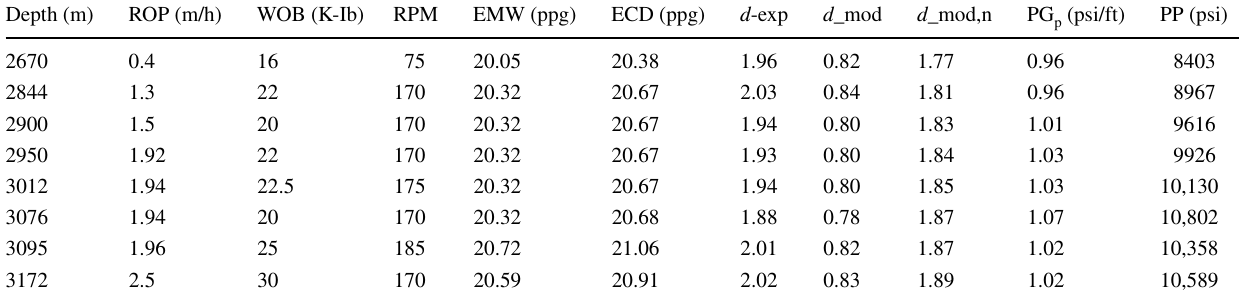
Table 10 Using Zamora’s d -exponent method to estimate pore pressure gradients of Gachsaran formation